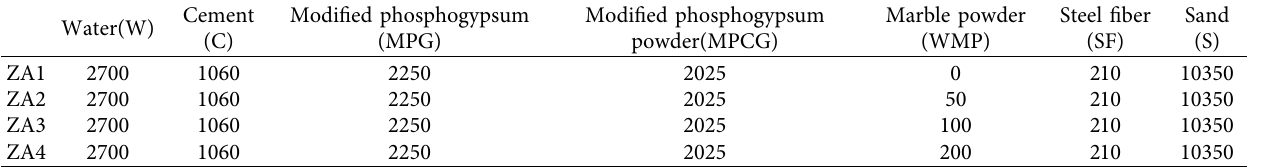
Table 17: Parallel tests of the optimum ratios affecting the compressive strength levels.